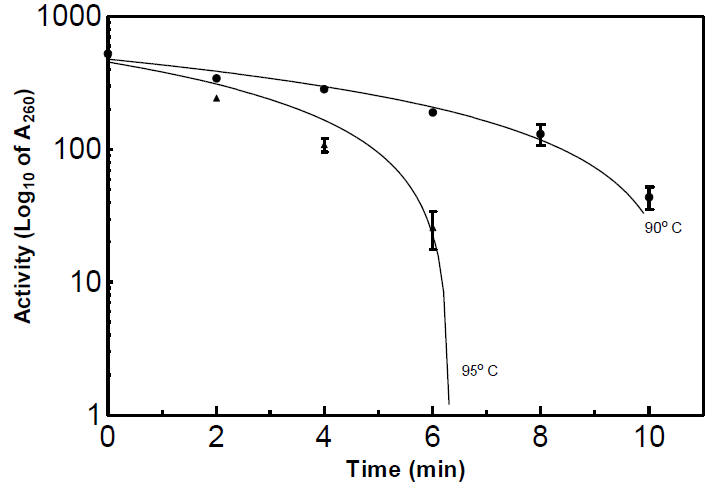
Figure 6. Plots of the denaturation of partially purified RNase at 90 and 95 °C. The